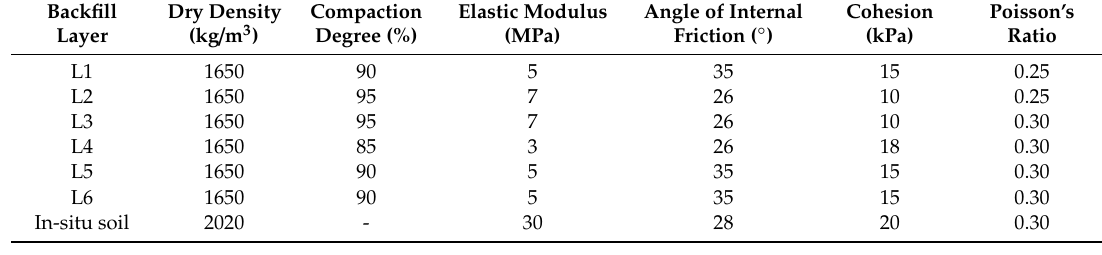
Figure 3. ( a ) Three-dimensional data of the road structure; ( b ) the layers of the road structure.